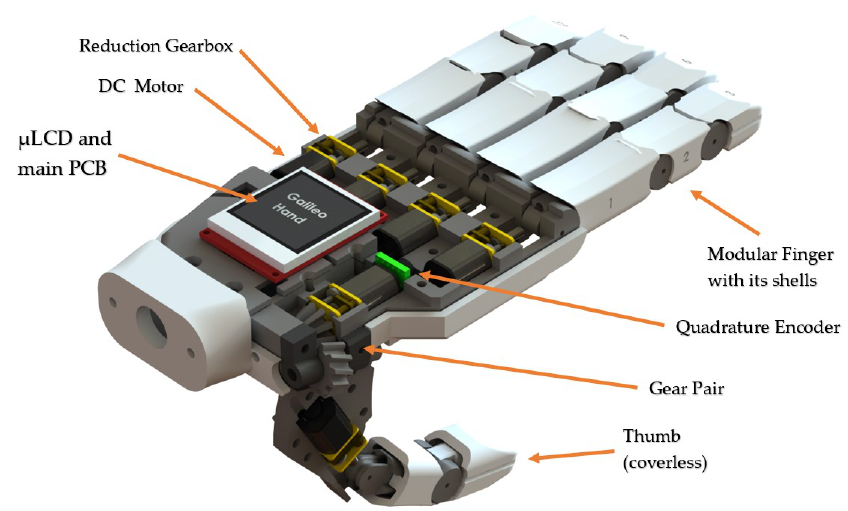
Figure 1. Galileo Hand: anthropomorphic, 3D-printed upper-limb prosthesis.